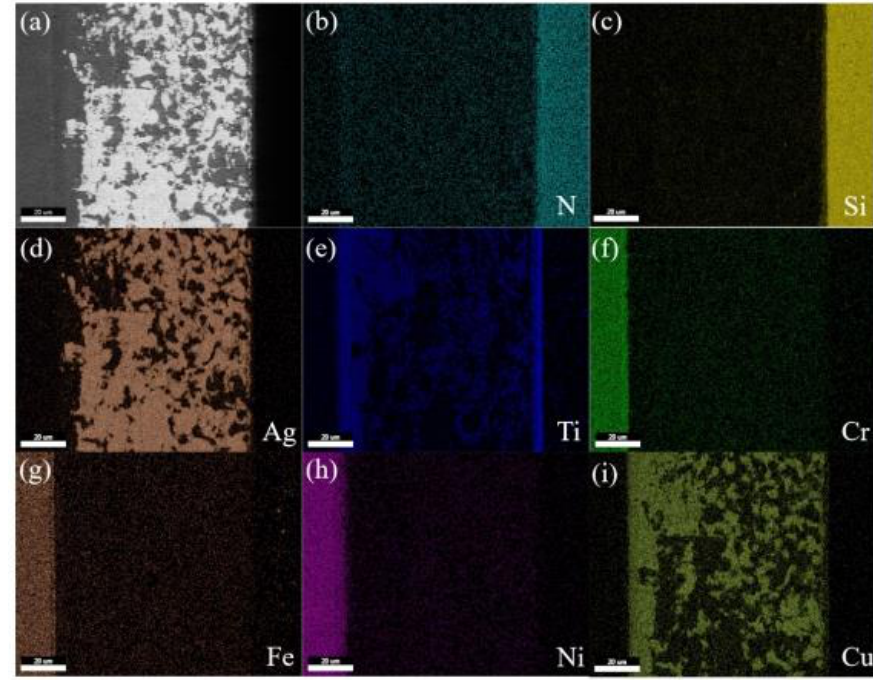
Figure 7. GH4169/Si 3 N 4 brazed joint interface (850 °C/15 min): ( a ) Microstructure; ( b – i ) main element plane distribution.